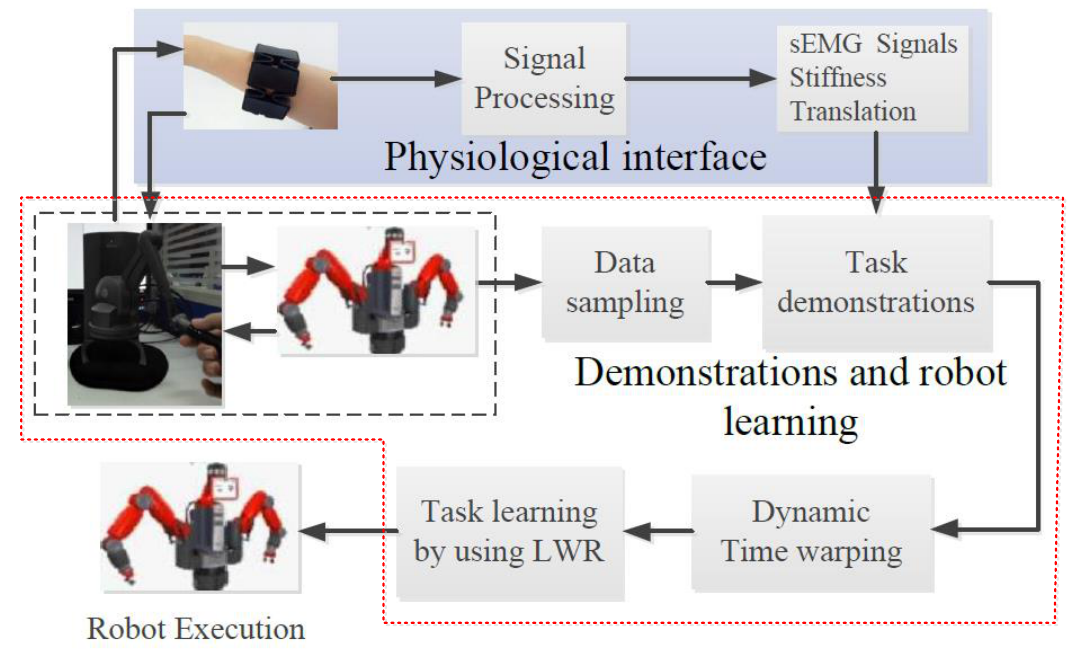
Figure 3. Schematic illustration of the proposed